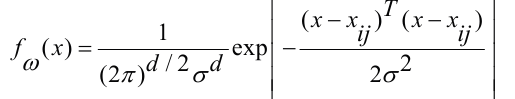
Leaping Algorithm 4.1. Polymerization Fault Diagnosis System Based on Rough Set and